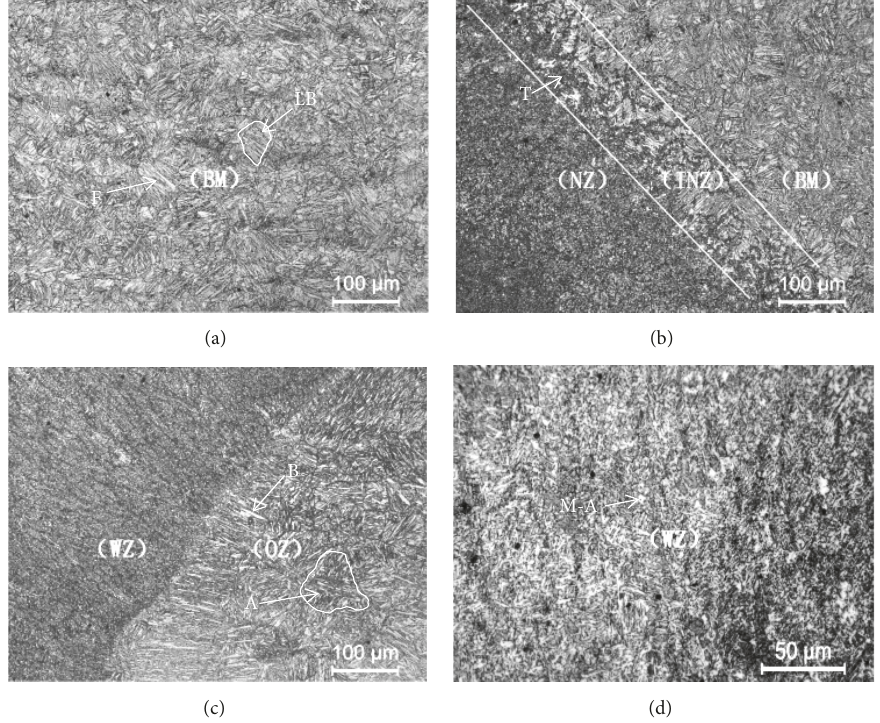
Figure 4: The microstructure of BM, INZ, NZ, OZ, and